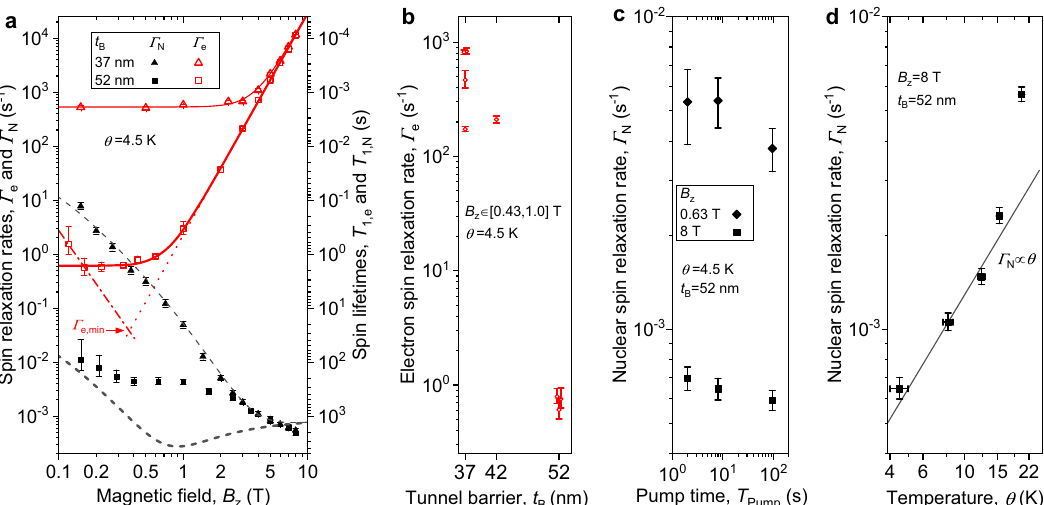
Fig. 3 Electron and nuclear spin dynamics in Coulomb blockade regime. a Magnetic fi eld dependence of the electron ( Γ e , open symbols) and nuclear ( Γ N , solid symbols) spin relaxation rates measured in a thin-barrier (triangles, t B = 37 nm) and thick-barrier (squares, t B = 52 nm) samples at base temperature θ ≈ 4.5 K. Tabulated experimental data can be found in Supplementary Note 3. Spin pumping time in nuclear spin relaxation experiments is T Pump = 8 s. Modelling is shown by the solid (electron) and dashed (nuclei) thin ( t B = 37 nm) and thick ( t B = 52 nm) lines. Dotted and dash-dotted lines show power-law extrapolations of the low- fi eld and high- fi eld regimes to estimate the minimum electron spin relaxation rate Γ e ; min (cid:3) ð 20s Þ (cid:2) 1 . b Γ e for several QDs in samples with t B = 37, 42 and 52 nm measured in low- fi eld regime B z ≤ 1 T, where spin relaxation is dominated by cotunneling. Small horizontal offsets are added to prevent points from overlapping. c Γ N measured as a function of the pump time in a thick-barrier sample at B z = 0.63 T (diamonds) and B z = 8 T (squares). d Γ N measured as a function of sample temperature in a thick-barrier sample at B z = 8 T (symbols). Line shows linear dependence. All error bars are 95% con fi dence intervals.